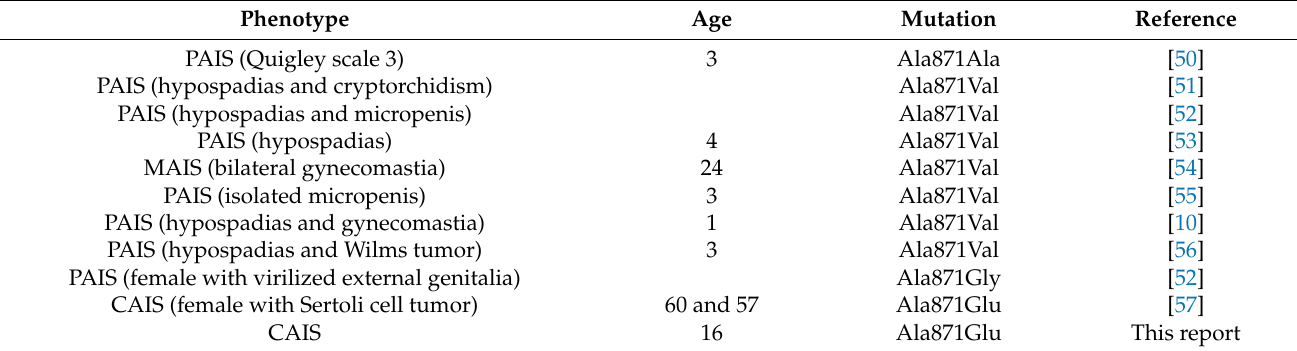
Table 2. Androgen receptor gene mutations in 871 codon and their